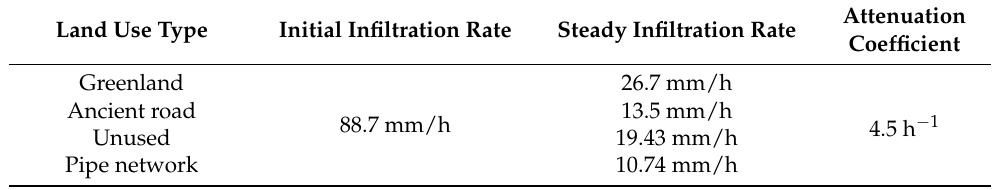
Table 1. The numerical value table of the infiltration parameters of the permeable surface.